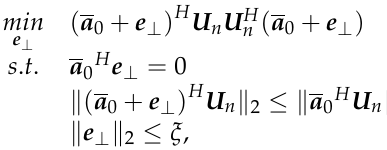
versus θ with fixed incident signal SNR = 5 dB ; 2